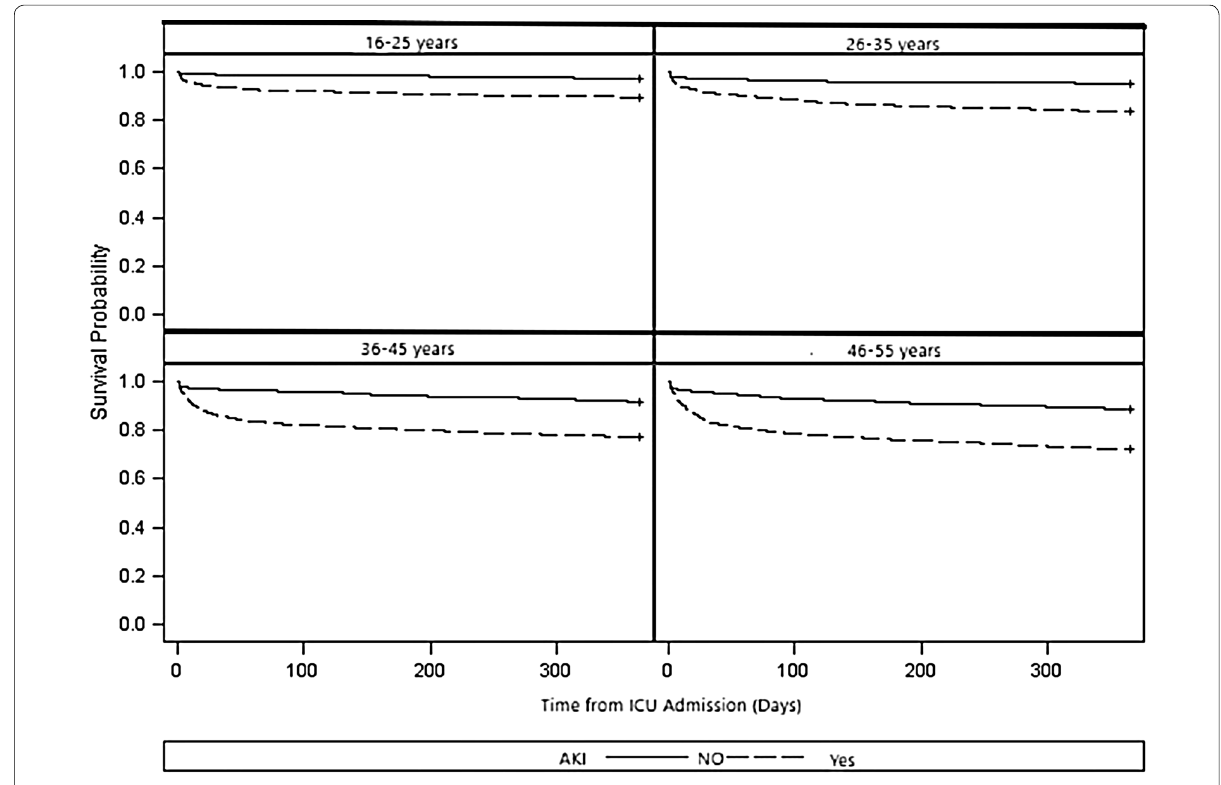
Fig. 2 Kaplan–Meier survival curves for 1‑year mortality after ICU